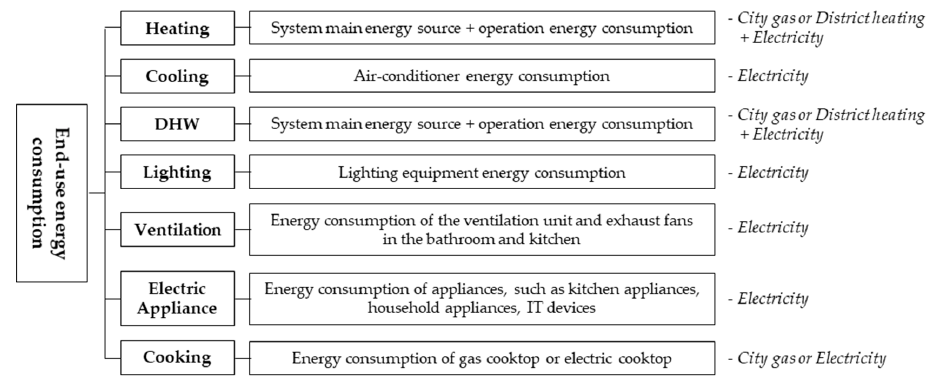
Figure 3. End-use energy-consumption classification and definitions.